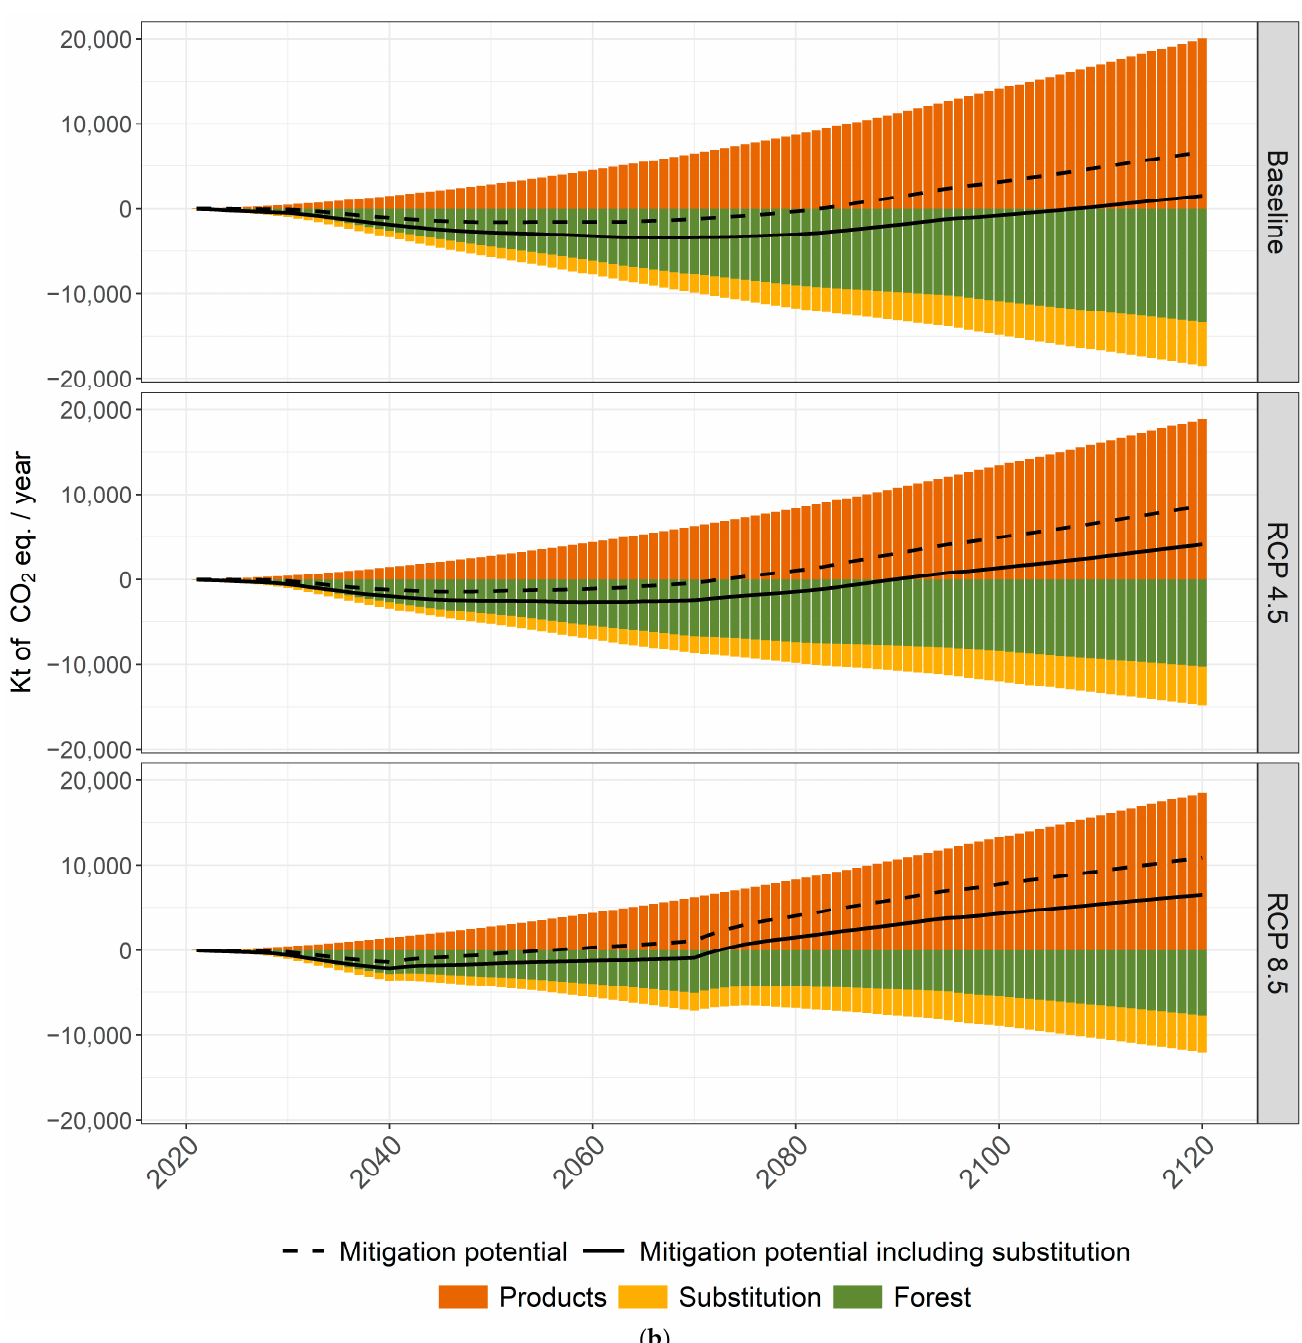
Figure 8. Mitigation potential of ecosystem-based forest management in Maskinongé compared to the conservation scenario presented on ( a ) an annual basis (in kt of CO 2 eq. year − 1 ) and ( b ) a cumulative basis (in kt of CO 2 eq.). The dashed line considers the sum of fluxes from forest ecosystem and wood product degradation; the solid line additionally assumes fluxes from the substitution effect of wood products on markets. Positive values indicate that ecosystem-based forest management causes a net increase of emissions to the atmosphere relative to conservation, while negative values indicate a net decrease (mitigation). Results are based on the average of five replicates.